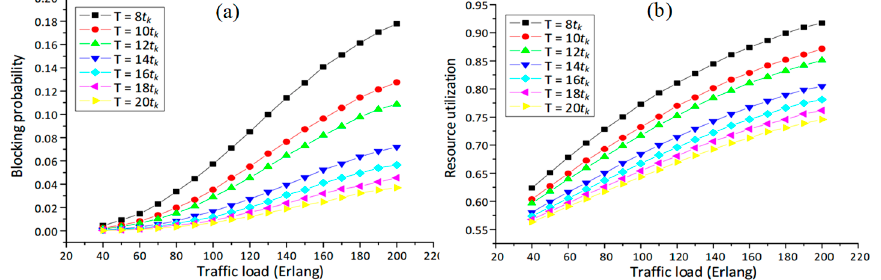
Figure 6. ( a ) The blocking probability, ( b ) the resource utilization.